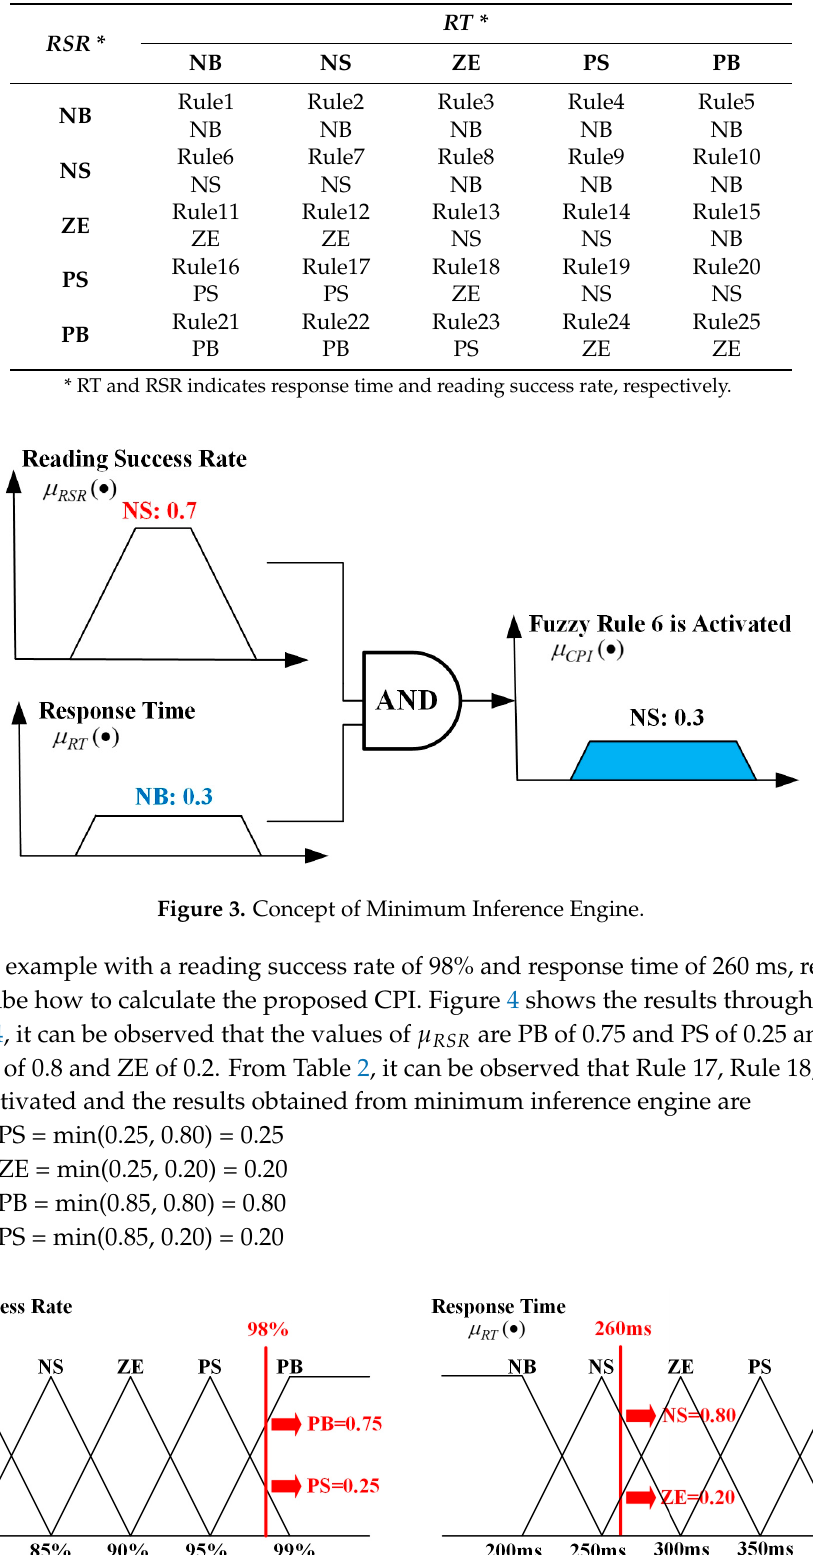
Table 1. Fuzzy Rules for Proposed CPI.